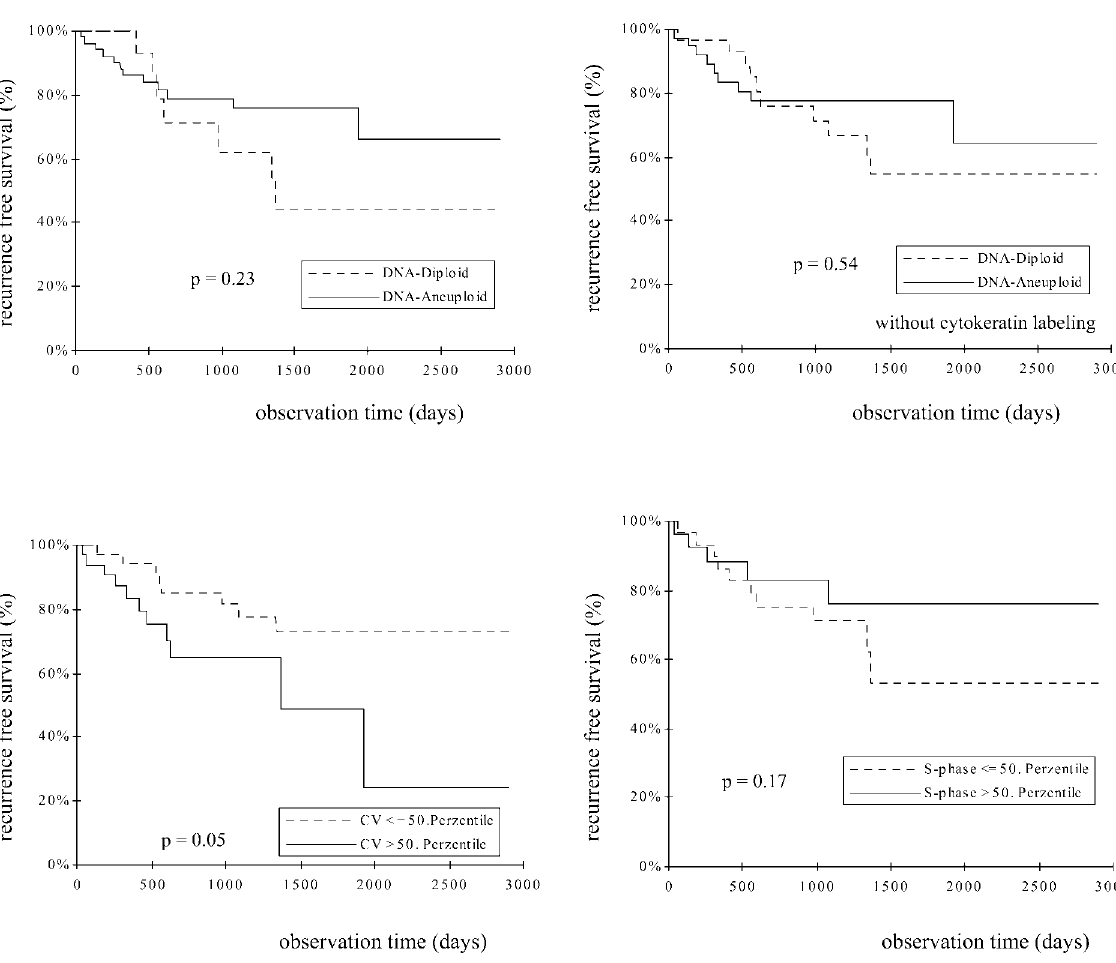
Fig. 1. Cervical cancer ( n = 69). Kaplan–Meier curves for RFS in dependence on DNA-ploidy (with and without cytokeratin labelling), CV and S-phase fraction were performed. The significance level ( p ) was determined by univariate analysis with the log rank test.